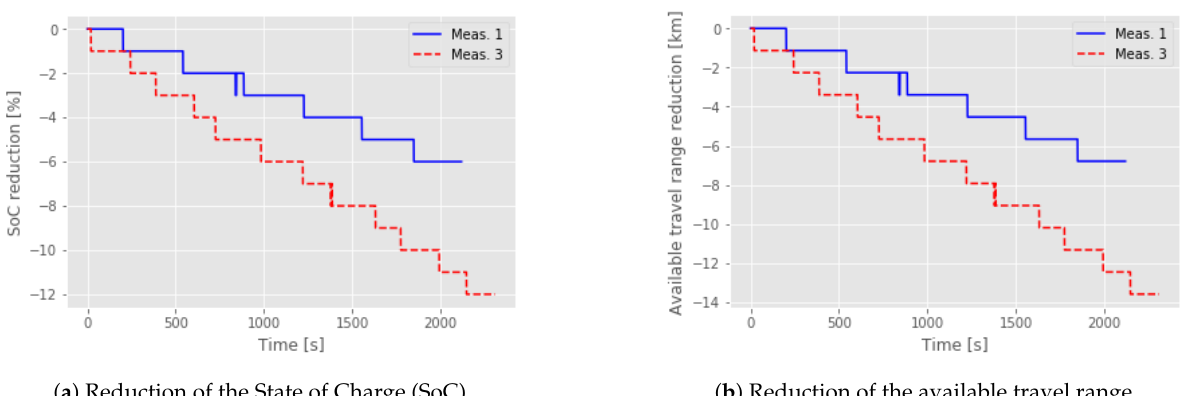
Figure 7. Comparison of the reduction of ( a ) the SoC and ( b ) of the available travel range in both cases of heating off (Meas. 1, blue, solid line) and on (Meas. 3, red, dashed line).